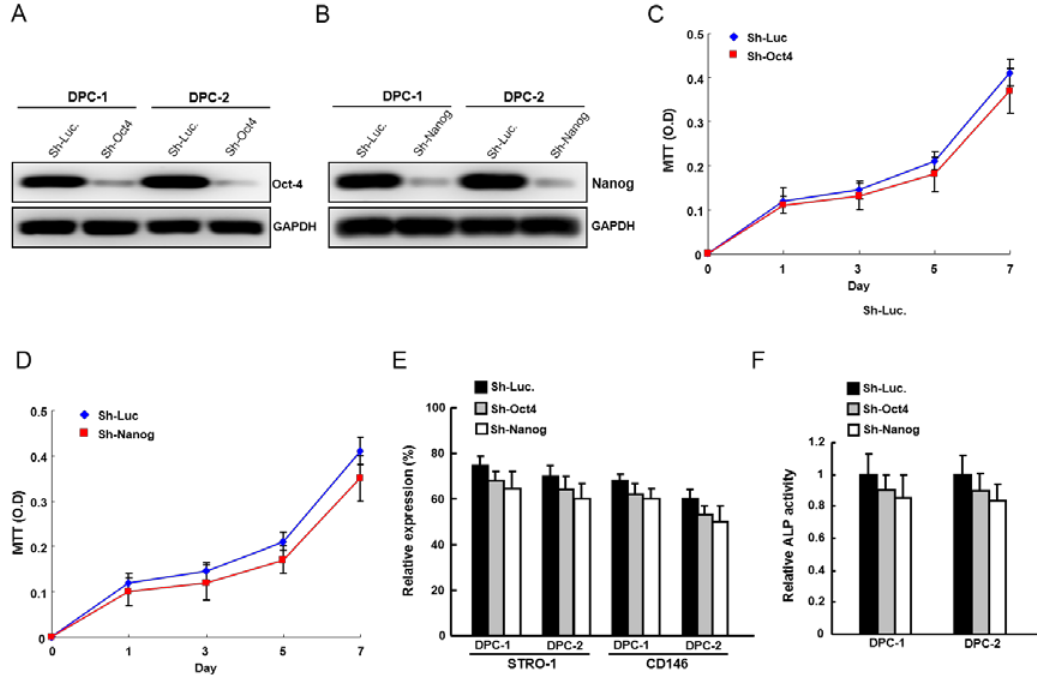
Figure 2. Depletion of Oct4 or Nanog expression did not affect proliferation rate and ALP activity in STRO-1 + CD146 + DPSCs. The silencing effect of Oct4 ( A ) or Nanog ( B ) shRNA in DPSCs was validated translationally by western blotting. Immunoblotting against anti-Oct4, anti-Nanog, or anti-GAPDH antibodies was performed as indicated; The amount of GAPDH protein of different crude cell extracts was referred to as loading control and for further quantification; The proliferation rate of sh- Oct4 ( C ) or sh- Nanog ( D ) in STRO-1 + CD146 + DPSCs was analyzed by a 3-(4,5-dimethylthiazol-2-yl) 2,5-diphenyl tetrazolium bromide (MTT) assay; ( E ) The expression of STRO-1 and CD146 of Oct4 or Nanog -knockdown DPSCs was analyzed by flow cytometry analysis; ( F ) ALP activity of Oct4 or Nanog knockdown DPSCs was analyzed. Data shown here are the mean ± SD of three independent